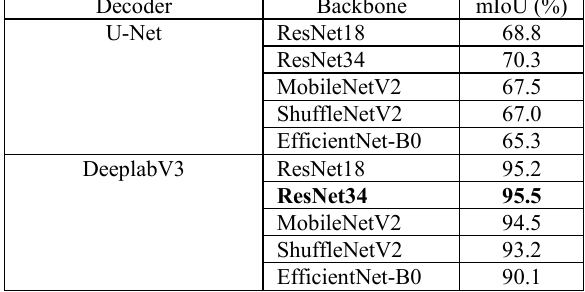
Table 2. Our simulated validation set results